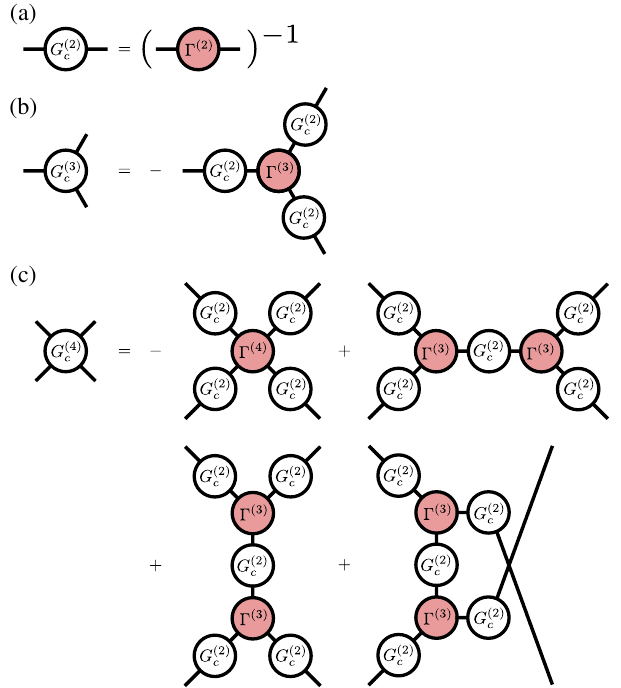
FIG. 2. Feynman diagrams relating connected and 1PI corre- lation functions. At second order (a), the correlators are each other ’ s inverse. At third order (b), the connected correlator is “ built ” from connected two-point functions that are connected by the irreducible three-vertex. At fourth order (c), the structure is similar to (b) with contributions from the four- and three-vertices. Given the 1PI vertices Γ ð n Þ , all connected correlations can be calculated by summing so-called tree diagrams, which separate into two disconnected parts upon cutting a single line G ð hence, do not contain any loop